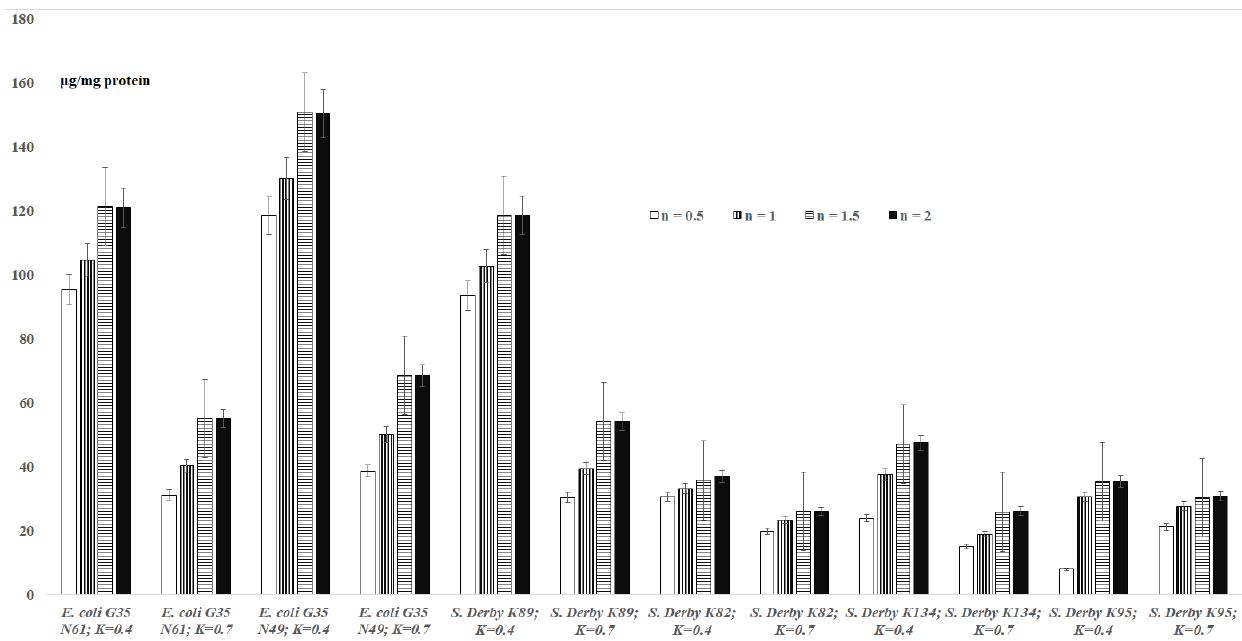
Figure 1. Levels of TBARs formed during lipid peroxidation processes in bacterial cells (suspensions; overage ± standard error) depending on the incubation time (n, hour); K —“OD 600 ”.